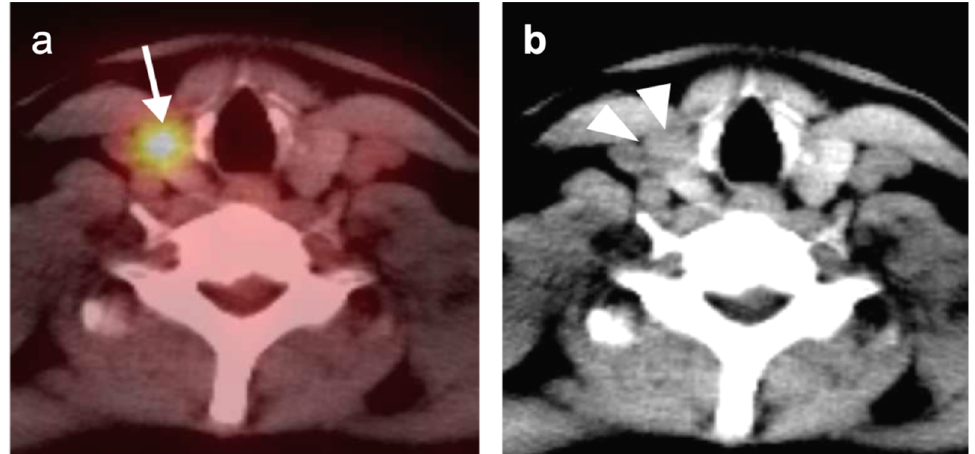
Figure 30. Hypermetabolic thyroid nodule (incidentaloma). A hypermetabolic 1.4 cm nodule on FDG PET-CT (( a ), white arrow) is lower in attenuation than surrounding thyroid tissue on CT (( b ), white arrowheads). The American Thyroid Association recommends FNA for hypermetabolic thyroid nodules > 1 cm in diameter.